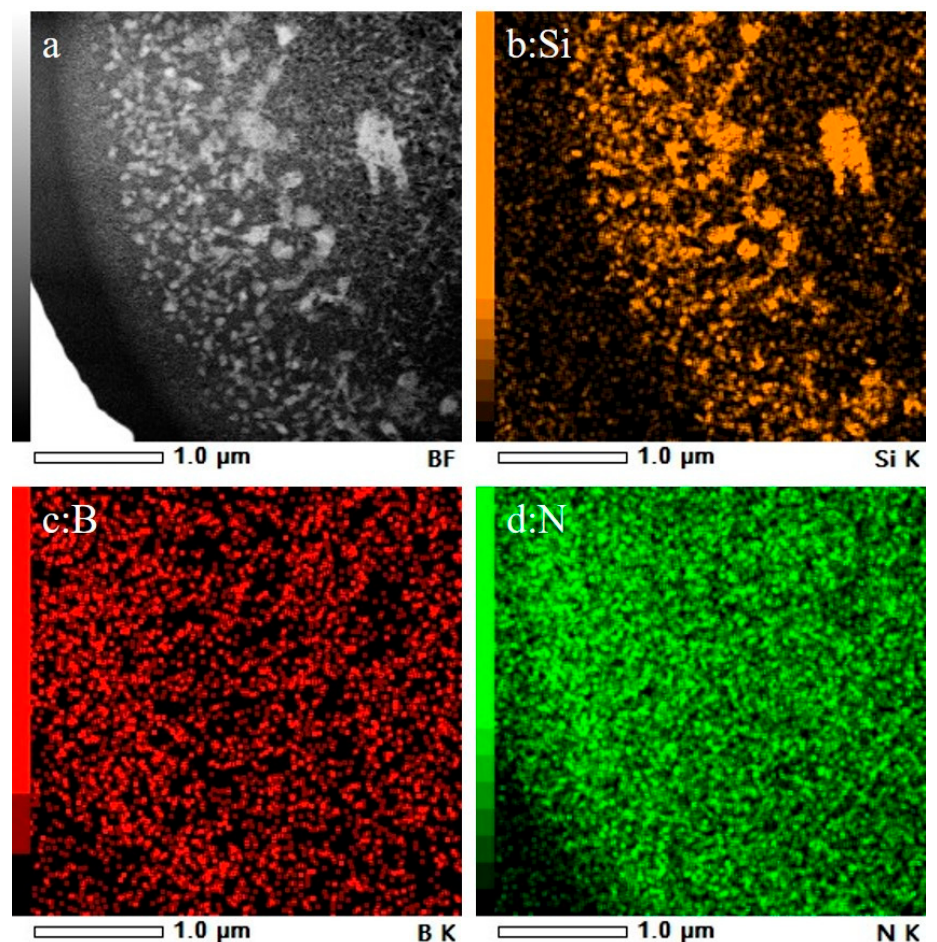
Figure 5. HAADF image ( a ) and element maps ( b – d ) in the composite fiber cross-section showing the constituent elements of Si ( b ), B ( c ), and N ( d ), revealing a heterogeneous distribution of Si and a homogeneous distribution of N.